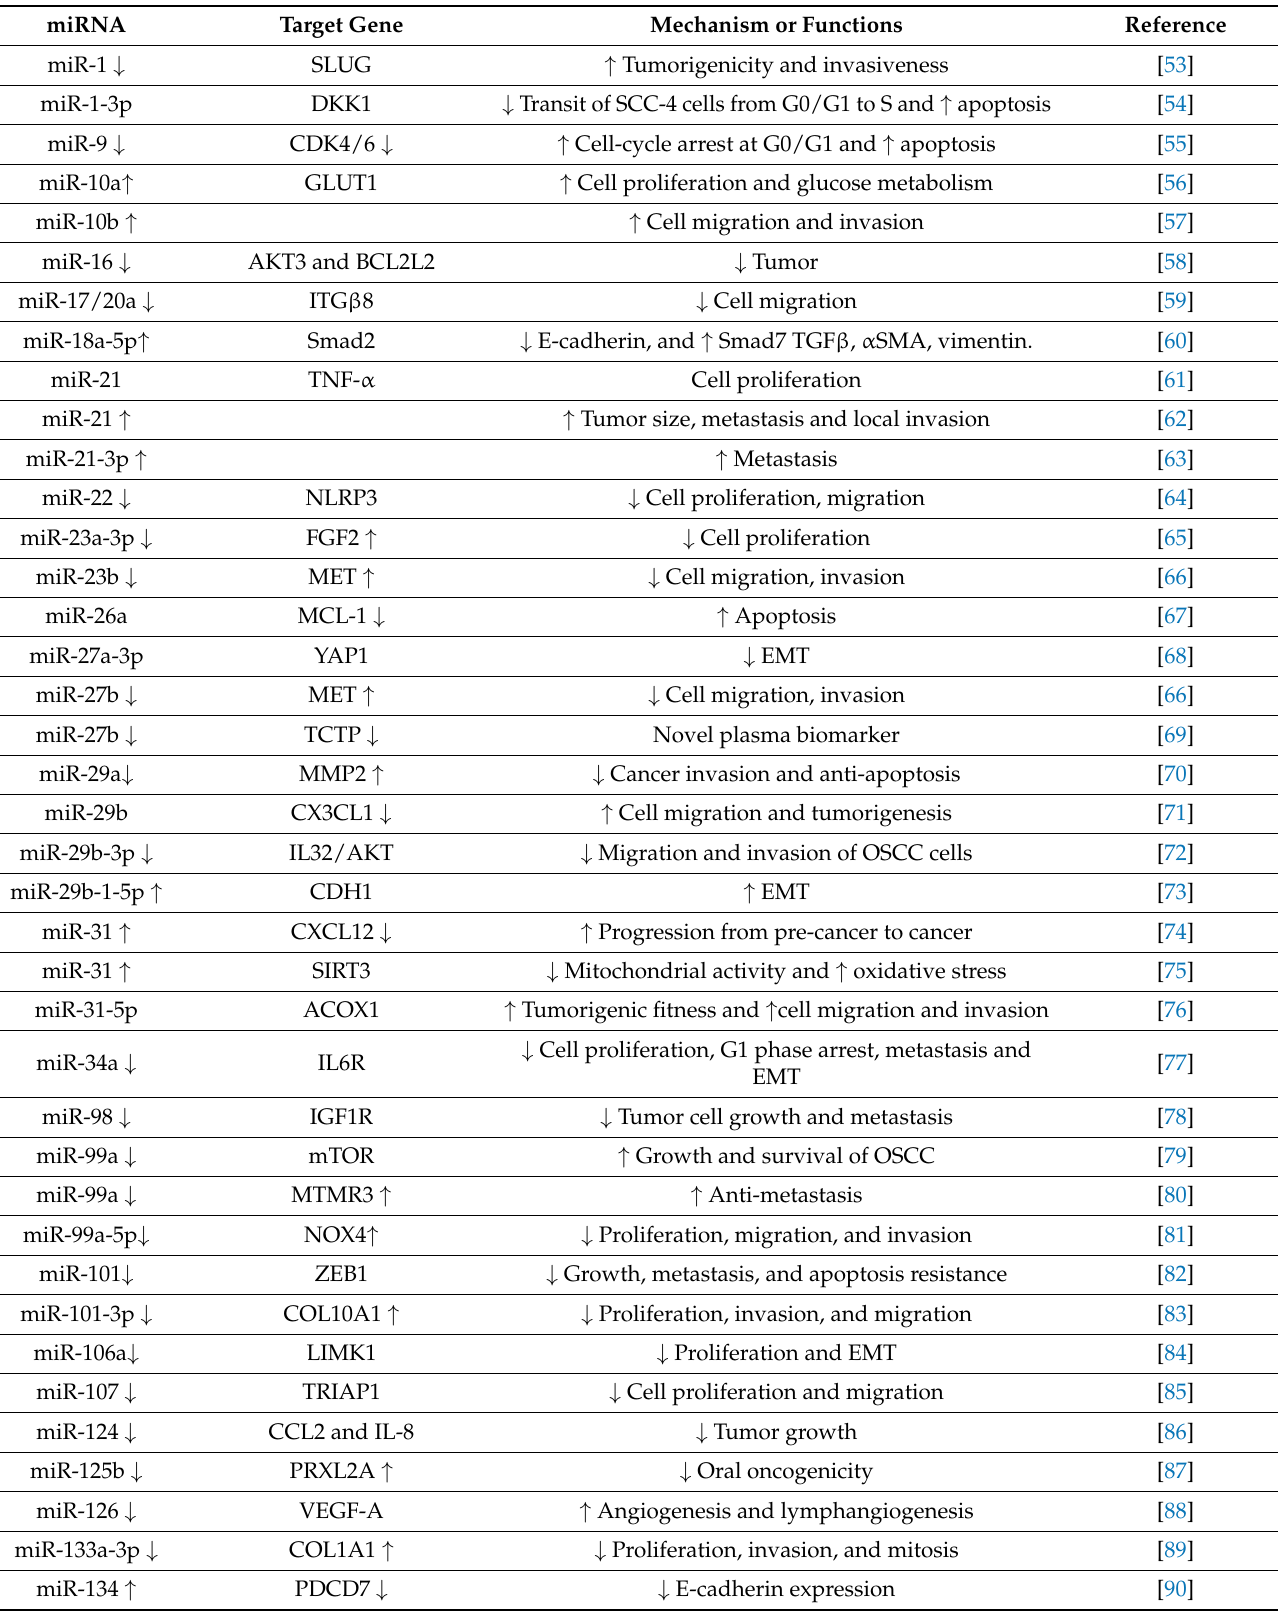
Table 1. Different microRNAs and their targets involved in oral cancer initiation and progression. miRNA Target Gene Mechanism or